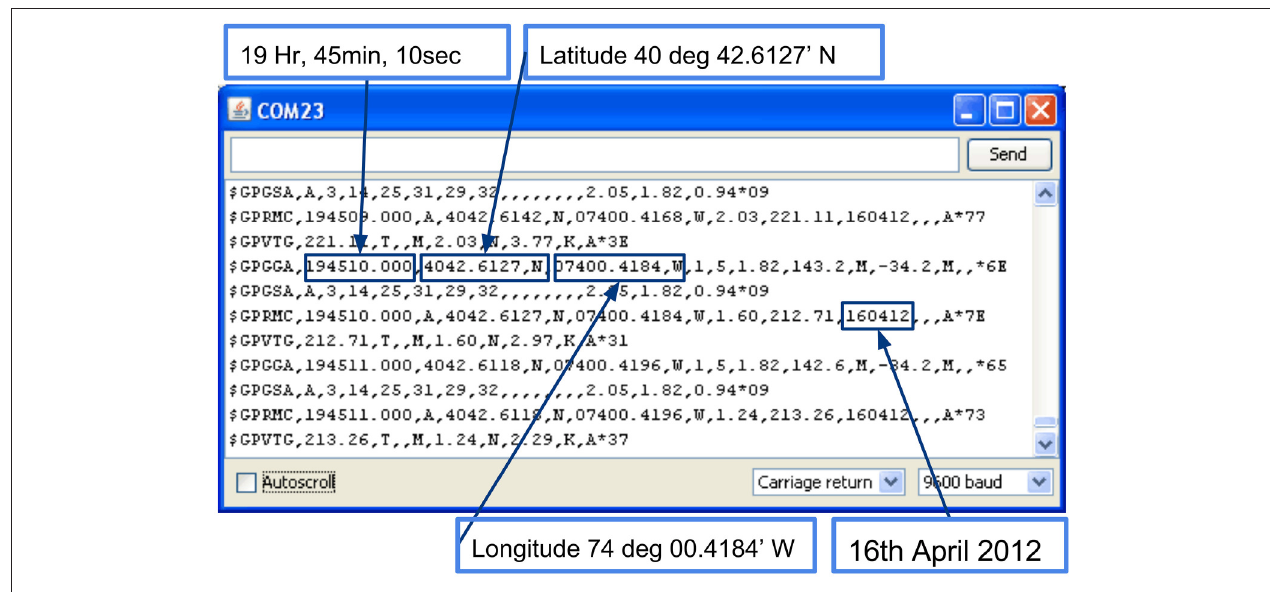
FIGURE 2 | Examples of NMEA